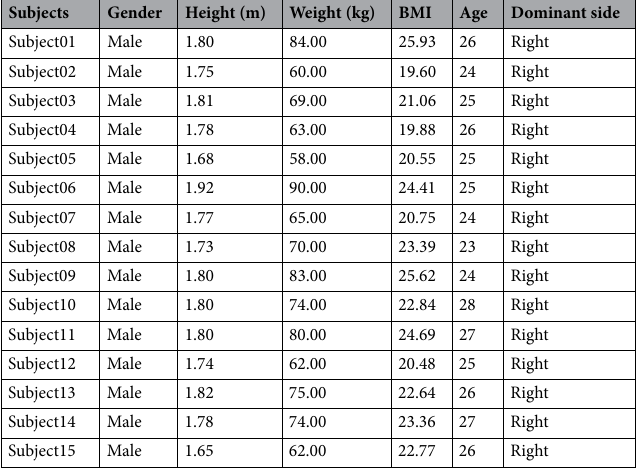
Table 1. Demographic data of enrolled subjects. BMI body mass